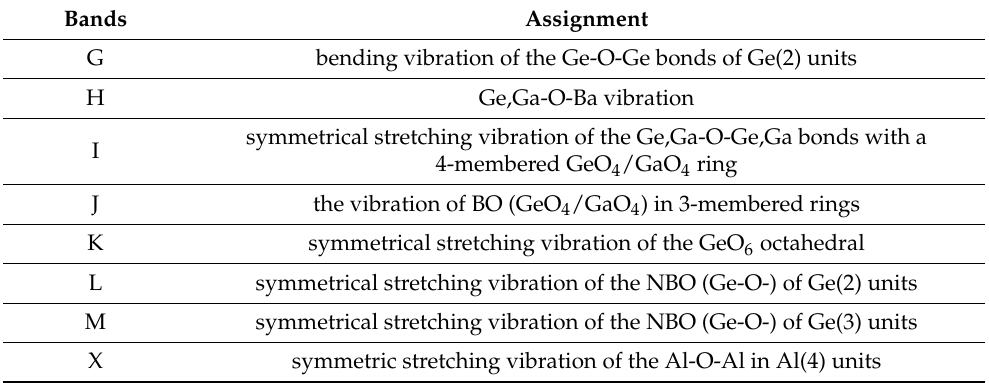
Table 3. Assignment of the bands in Raman spectra of glasses.